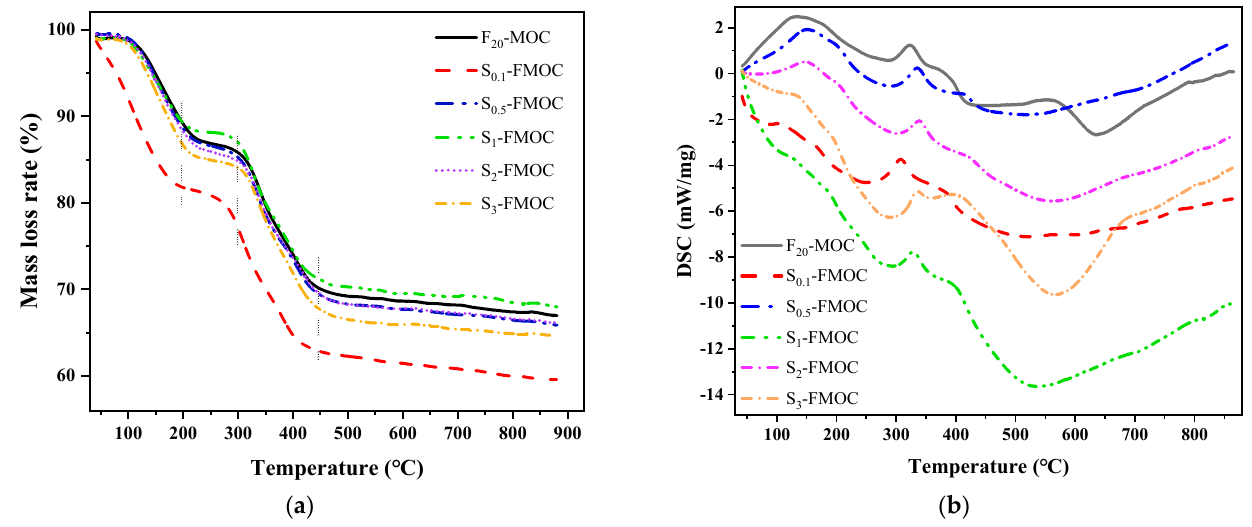
Figure 14. TG/DSC curves of hardened and multi ‐ doped MOC, ( a ) TG curves, ( b ) DSC curves. During the analysis, the weight loss and differential calorific value of MOC samples were measured. As shown in Figure 14a,b, when fly ash was mixed with HDTMS simultaneously, the weight loss process of MOC was not affected, but the differential heat will change, to a certain extent. In Figure 14a, the TG curves of MOC samples doped with fly ash and different proportions of HDTMS are shown. The mass loss ratio was the same for all MOC samples (including modified and reference samples) in the 200–500 °C range, indicating that the combined action of fly ash and HDTMS did not affect the mass loss